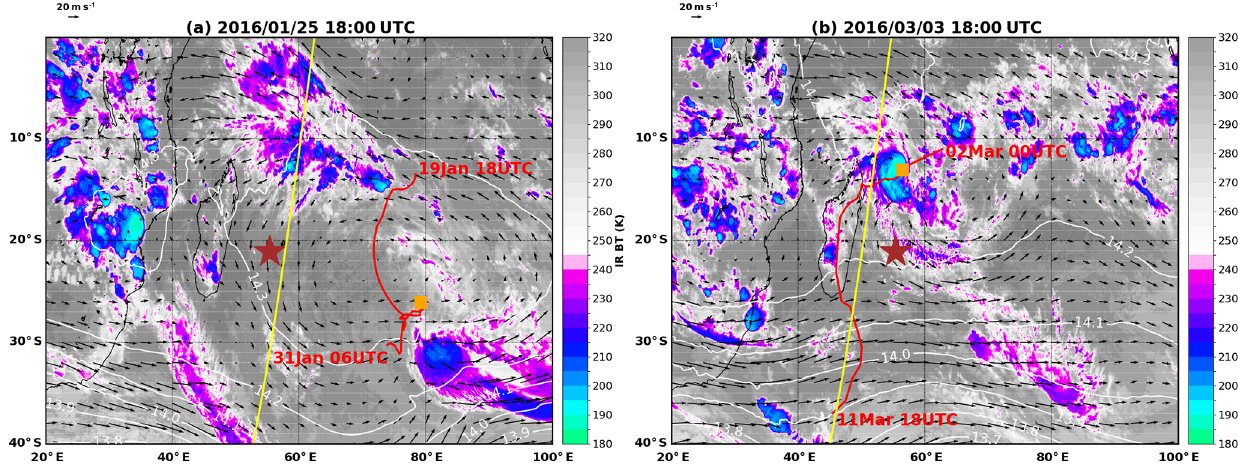
Figure 1. Infrared (10.8µm) brightness temperature (K) observed by Meteosat-7 at the time of the CFH launch for 25 January 2016 at 18:00UTC (a) and 3 March 2017 at 18:00UTC (b) . The red lines correspond to the best tracks of TS Corentin (19–31 January 2016) and TC Enawo (2–11 March 2017). The orange squares indicate the positions of the TC centers (defined as the minimum pressure in the Météo- France best track data) at the time of the satellite observation. The brown stars indicate the position of the Maïdo Observatory on Réunion Island (21.08 ◦ S, 55.38 ◦ E). The yellow lines correspond to CALIPSO orbit tracks on 25 January 2016 at 21:06UTC and 3 March 2017 at 21:41UTC. Arrows on the maps represent the wind field at 150hPa from the ECMWF analyses at 18:00UTC. The white contours indicate ECMWF geopotential heights at 150hPa.